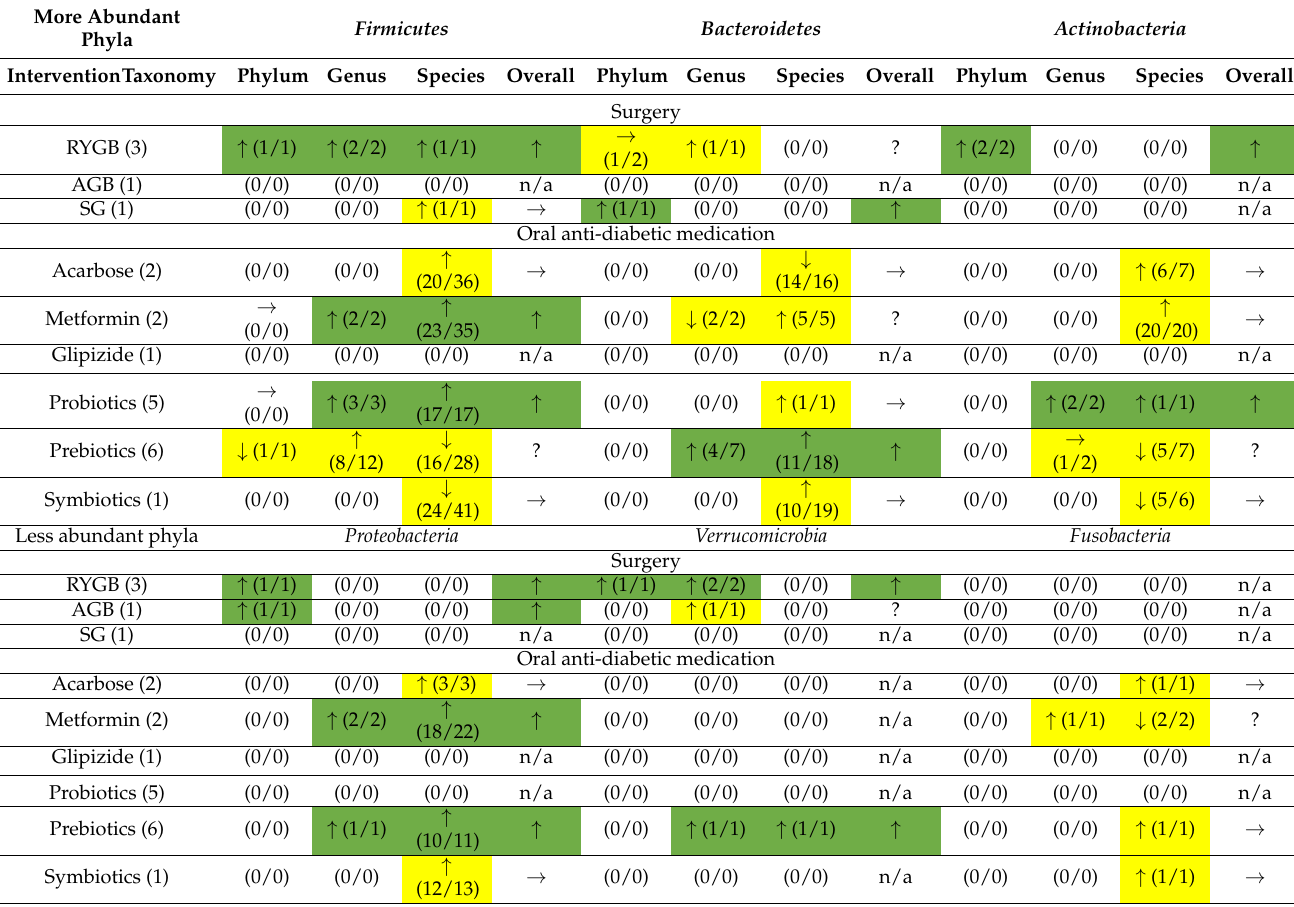
Table 4. Summary of significant phylum, genus, and species level microflora alterations after different type 2 diabetes treatment